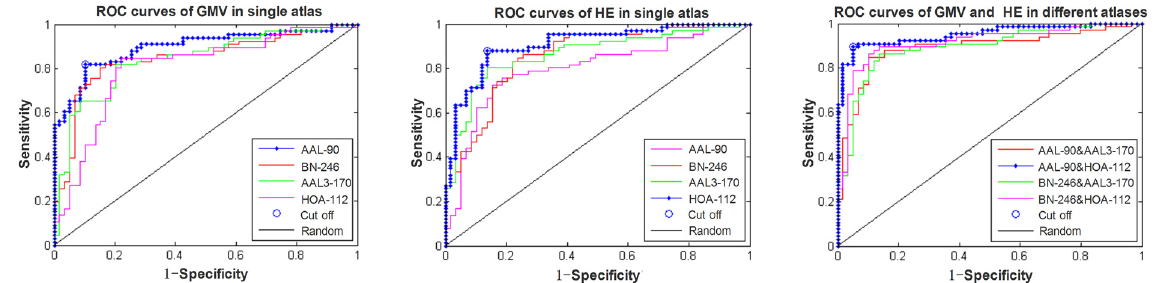
Figure 2. The ROC curves of the single-modality and multi-modality models.